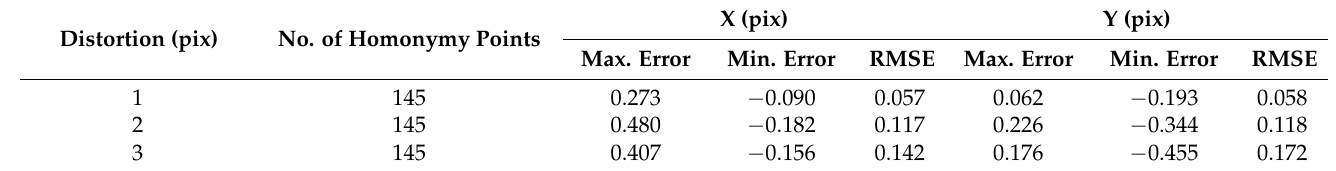
Table 8. Stitching error of EA-stable-3 (left-middle